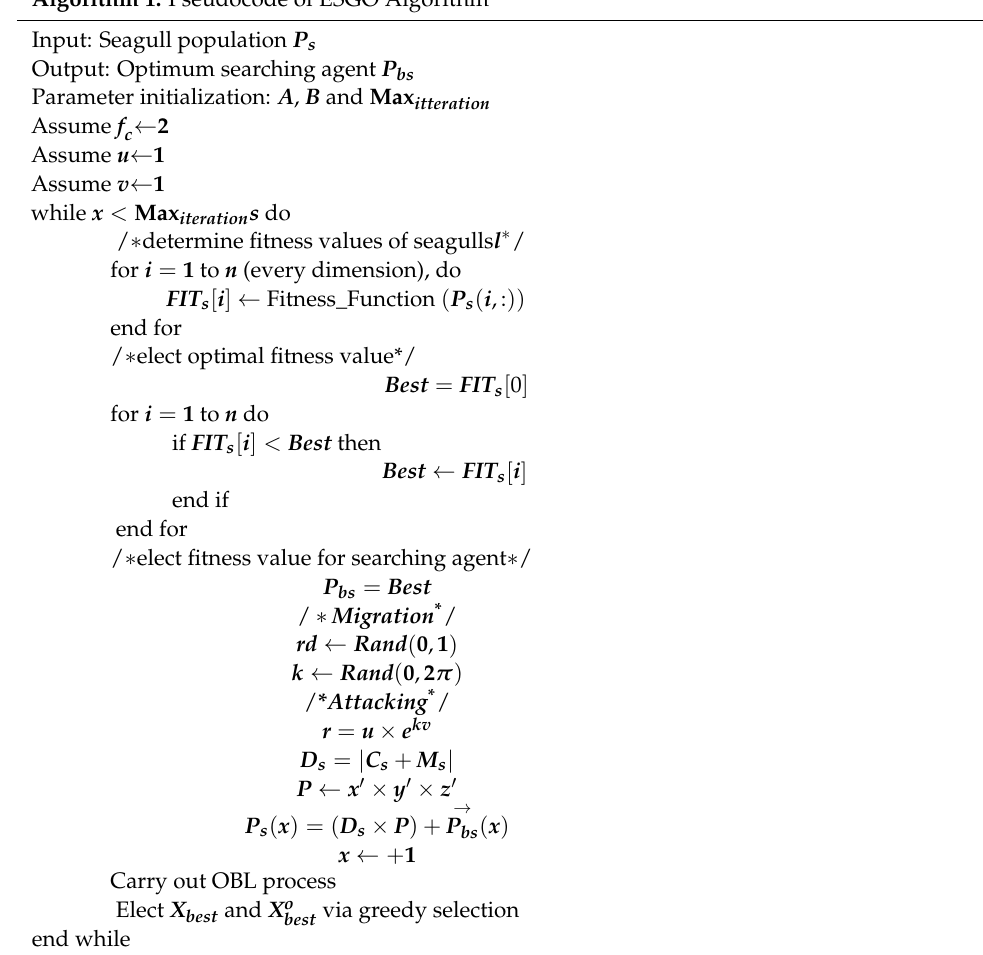
Algorithm 1: Pseudocode of ESGO